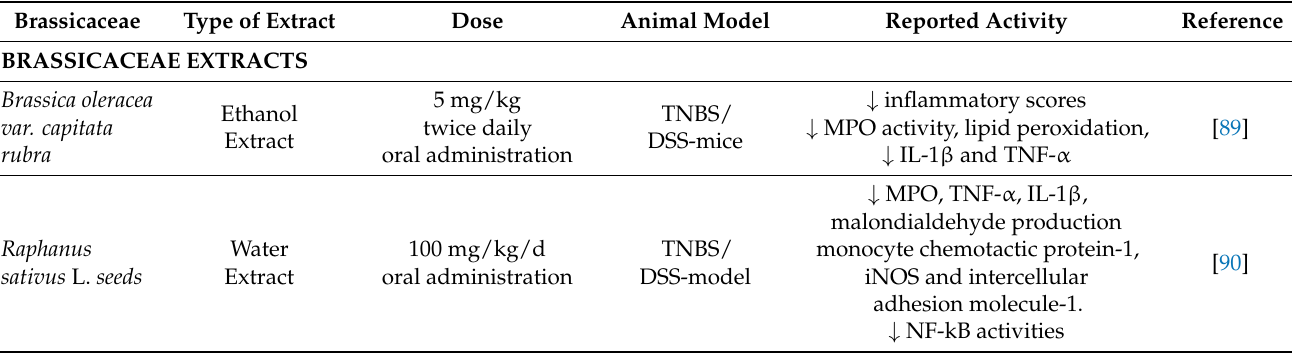
Table 2. In vivo effects of Brassicaceae on animal model of